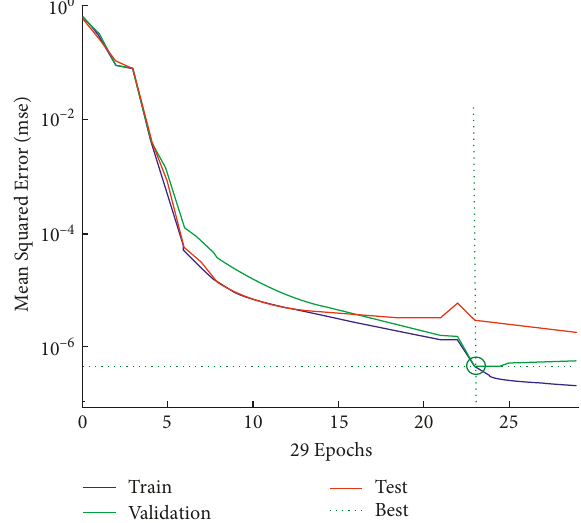
Figure 8: Training curve of RBF neural network.